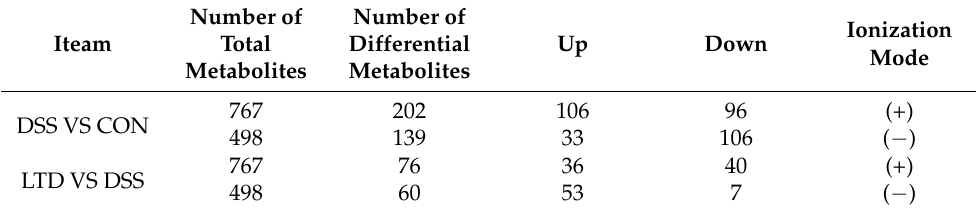
Table 1. The number of metabolites in CON, DSS and LTD groups.